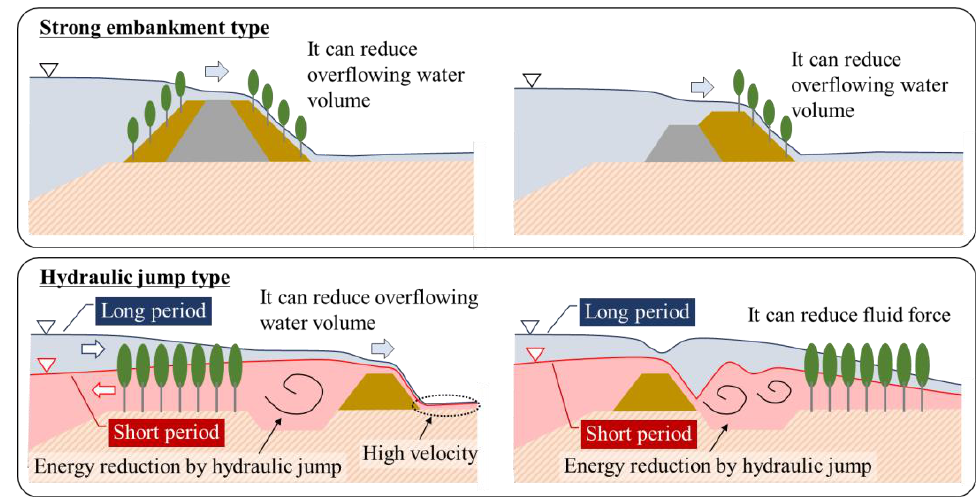
Figure 13. Schematic of hybrid structures and their classification.